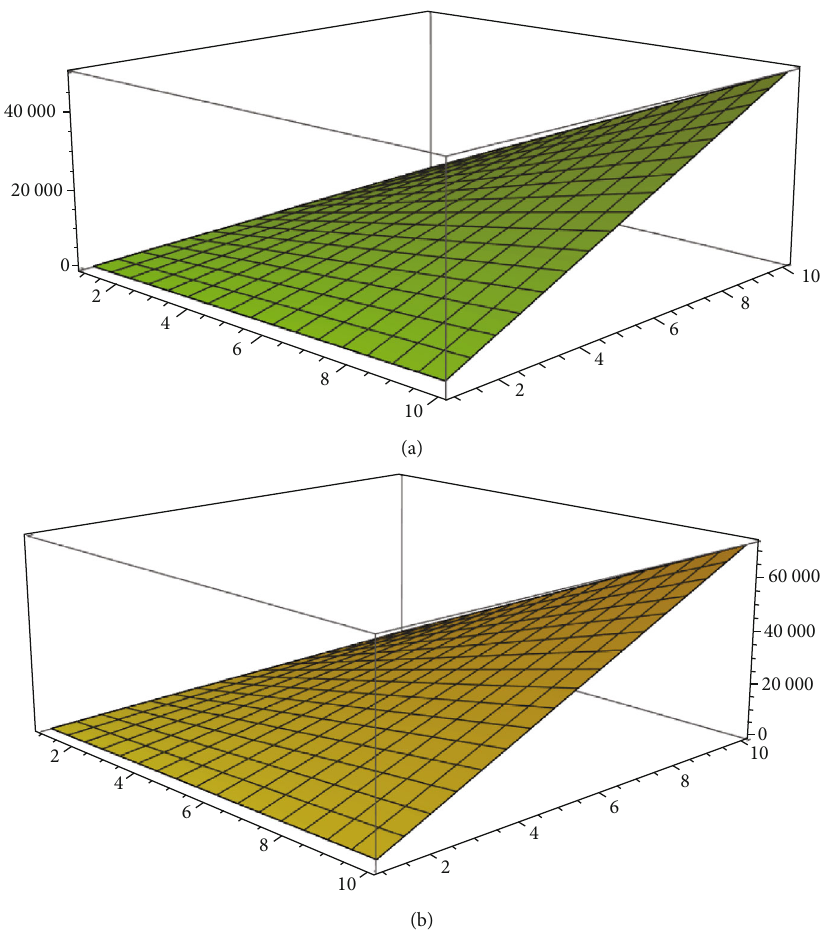
Figure 3: (a) Ev-deg M-index and (b) fi rst ve-deg Zagreb alpha